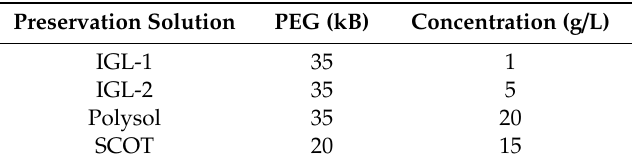
Table 1. PEG-based preservation